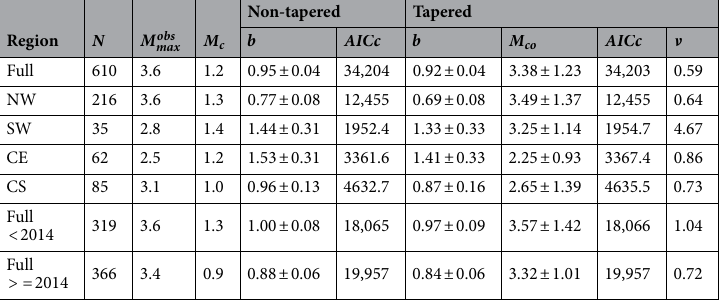
b is the b -value estimate with its